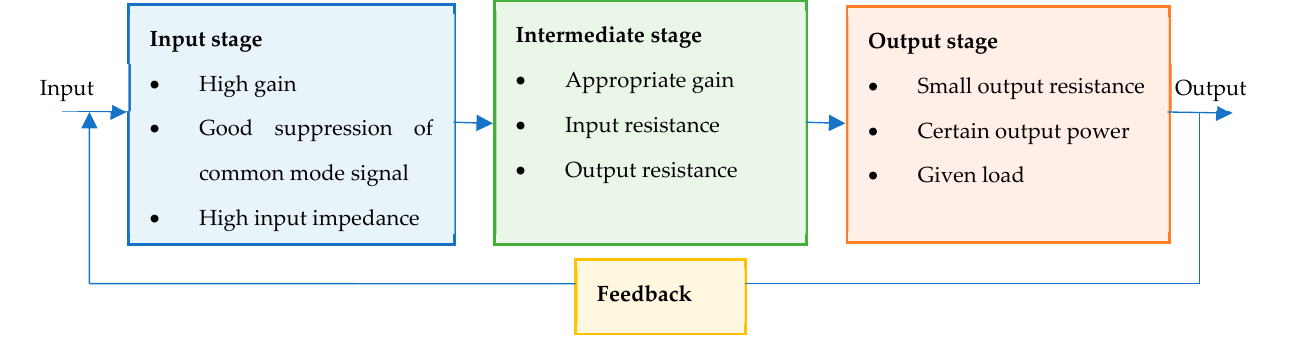
Figure 3. Structure of a multi-stage amplifier.